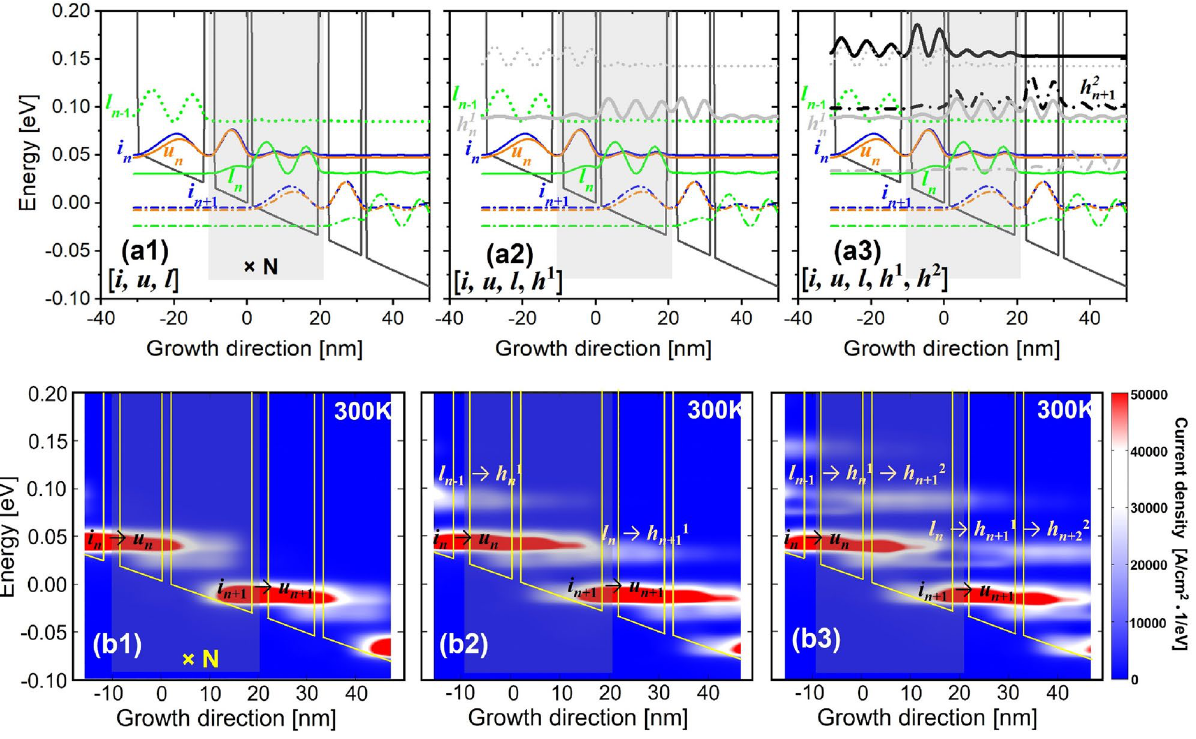
Figure 4. Current density mappings resolved by position and energy at high temperature of 300 K as the HLS is included one by one. ( a1 , b1 ) for [ i , u , l ], ( a2 , b2 ) for [ i , u , l , h 1 ], ( a3 , b3 ) for [ i , u , l , h 1 , h 2